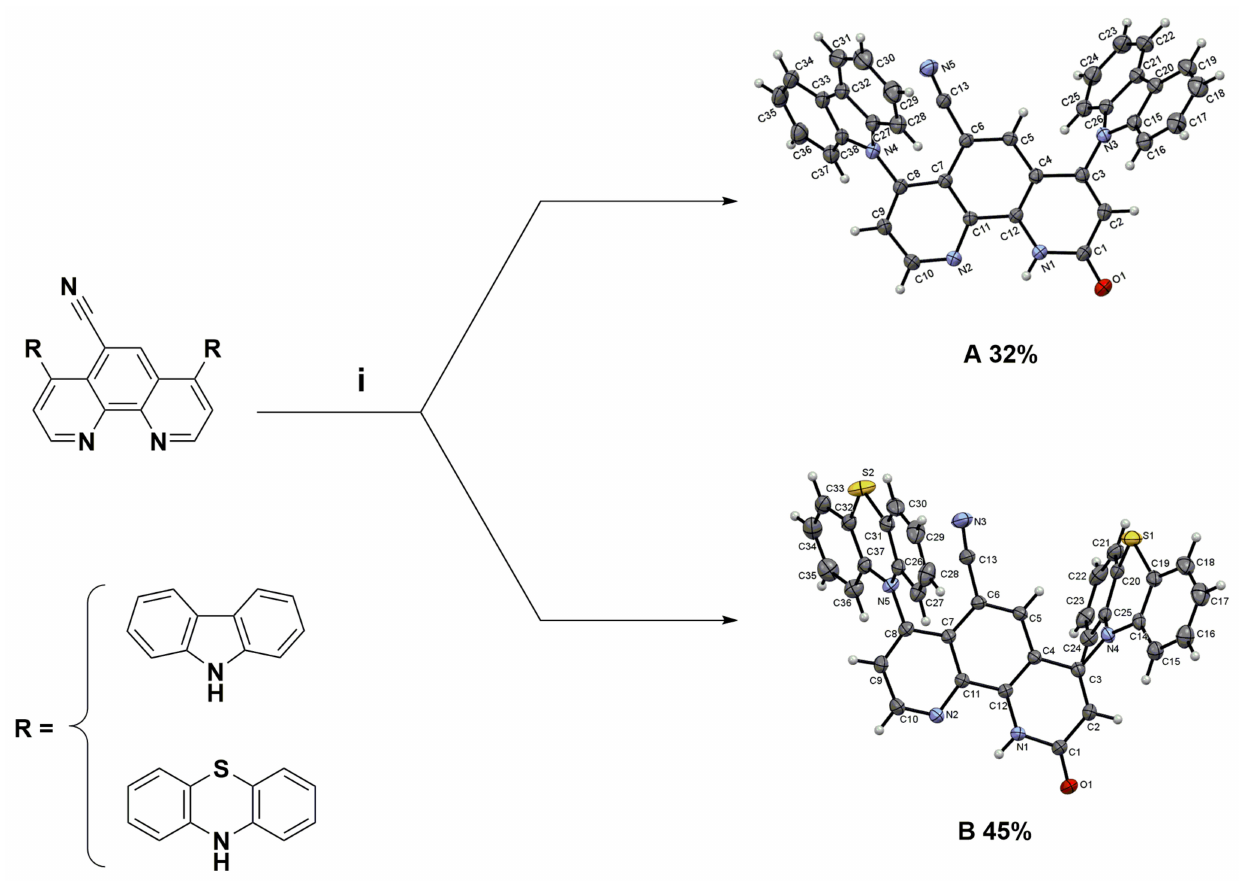
Figure 1. Structural formula of 4,7-di(9 H -carbazol-9-yl)-9-oxo-9,10-dihydro-1,10-phenanthroline-5-carbonitrile ( A ) and 2-oxo-4,7-di(10 H -phenothiazin-10-yl)-1,2-dihydro-1,10-phenanthroline-5-carbonitrile ( B ). Reagents and conditions: ( i ) 10% NaOH, tetrahydrofuran (THF), 60 ◦ C, 4 days